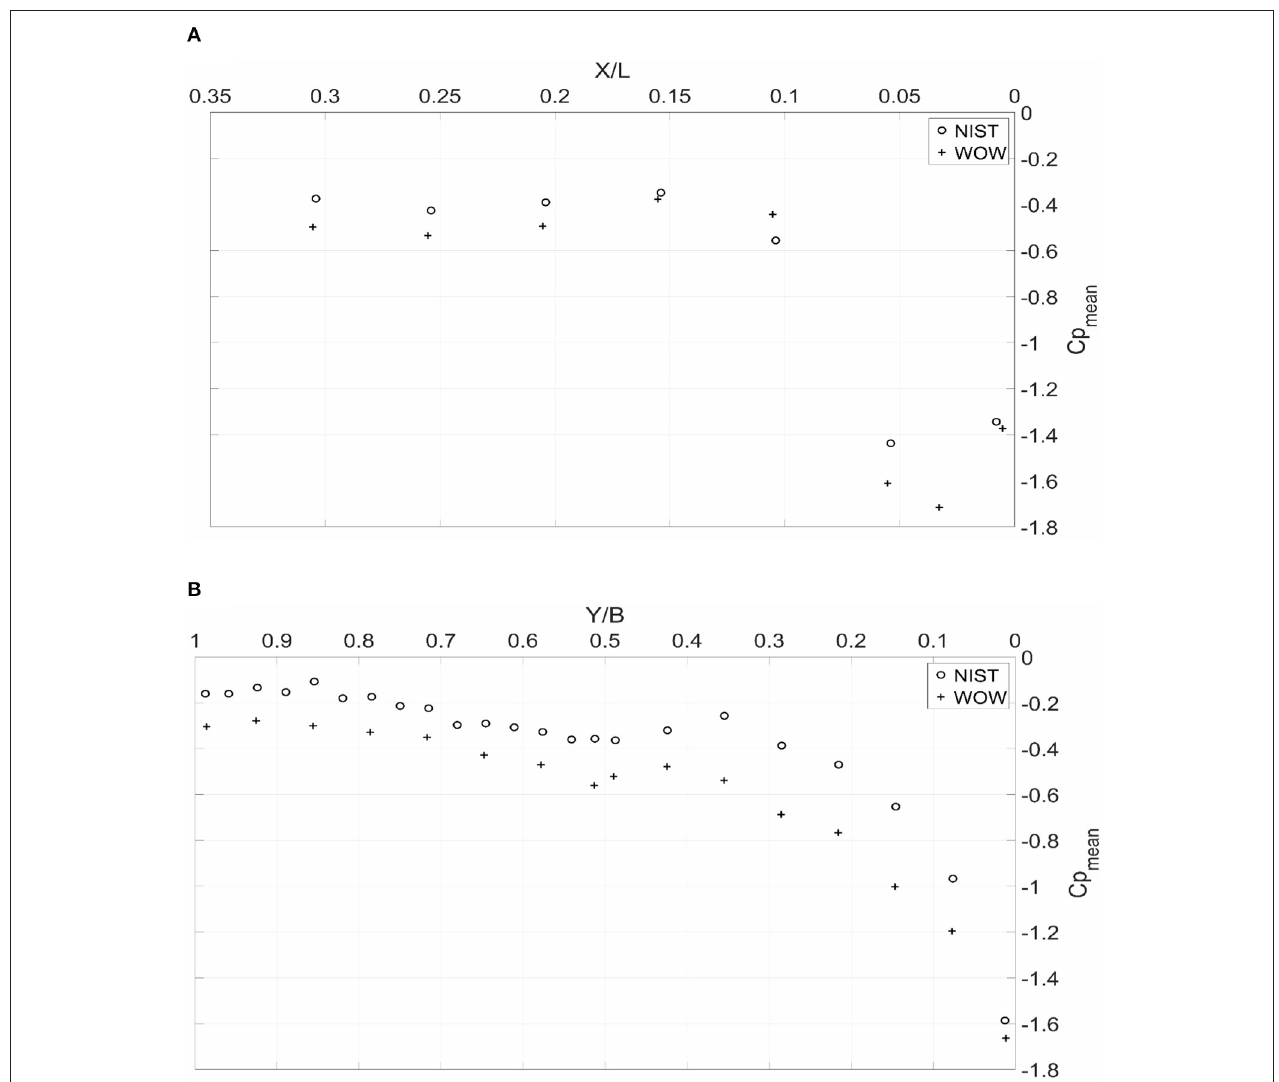
FIGURE 8 | Cp mean variation along: (A) the ridge at 45 ◦ wind direction, and (B) the gable end at 90 ◦ wind